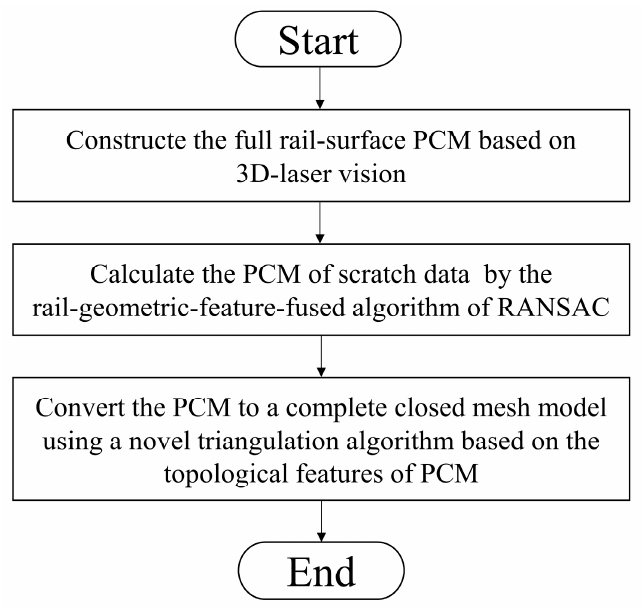
Figure 1. Flowchart of the proposed method.